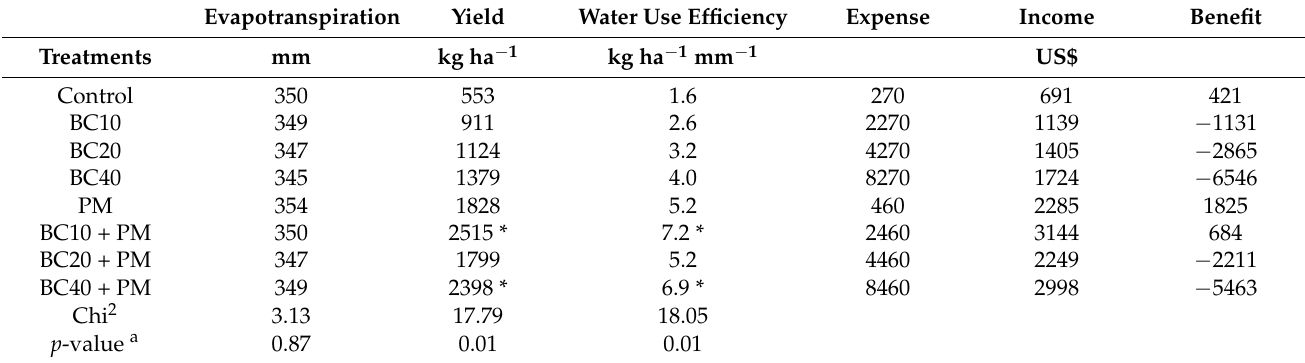
Table 6. Effects of biochar (BC), applied at 10, 20 or 40 t ha − 1 , and poultry manure (PM, 5 t ha − 1 ) on evapotranspiration, yield, and water use efficiency of common bean and on economic expense, income, and